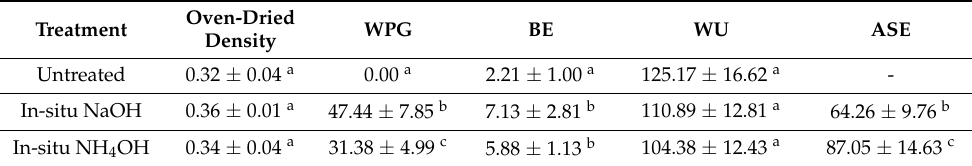
Table 1. Data on the dimensional stability of magnetic jabon wood.